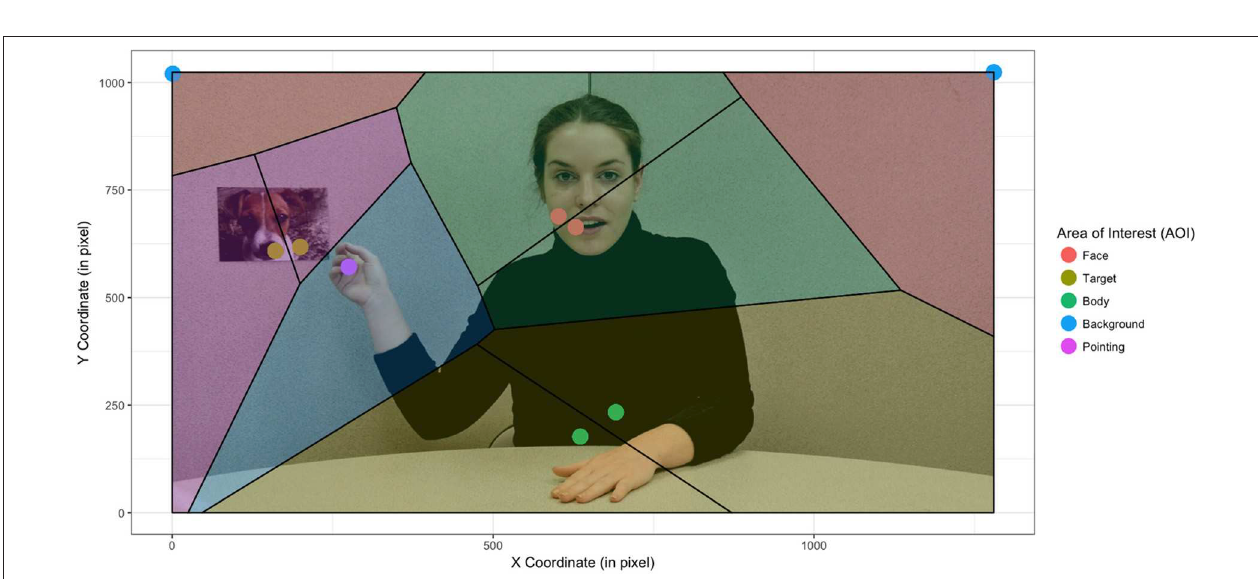
FIGURE 2 | Creation of cells by the Voronoi method based on the fixation centroids independently of group and stimulus condition (static vs. dynamic). The actress was informed and gave her written consent for scientific publication of her image.